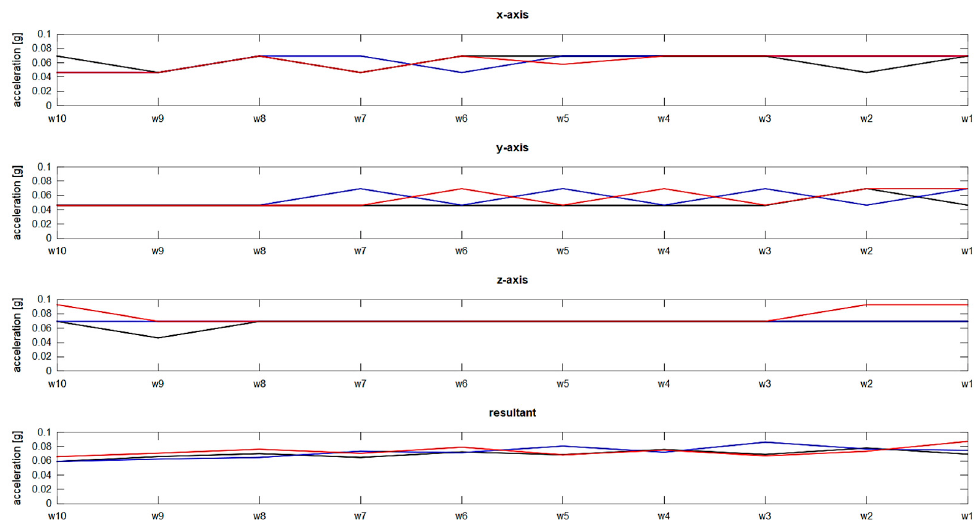
Figure 4. Median values of the ROM for the three axes and the resultant acceleration of the string arm. Every graph contains the values for C1 (black), C2 (blue) and C3